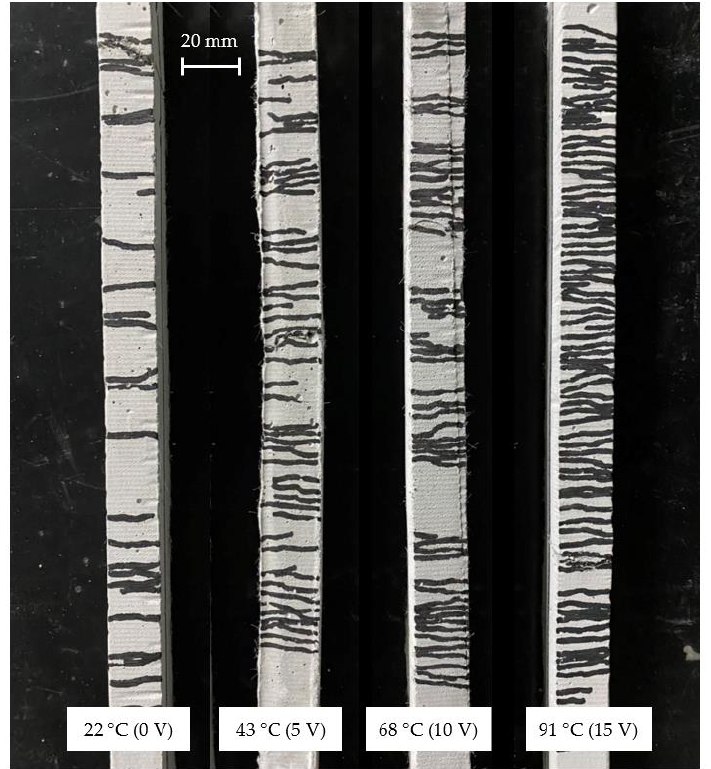
Figure 10. Surface temperatur − shrinkage strain relationship of TCPA.